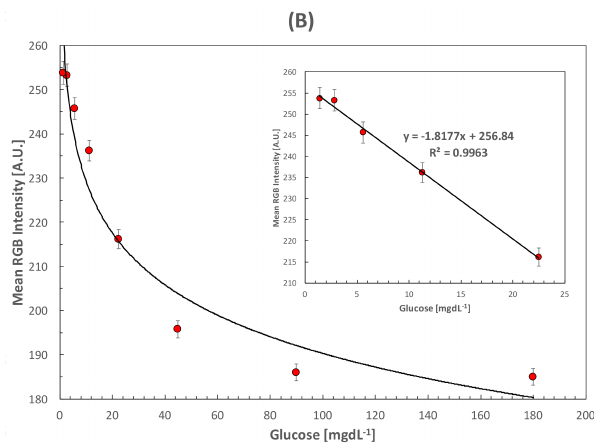
Figure 5. ( A ) Calibration curve obtained for glucose detection in PBS with an inset showing the linear zone; ( B ) Calibration curve obtained for glucose detection in artificial saliva and the augmented linear zone.